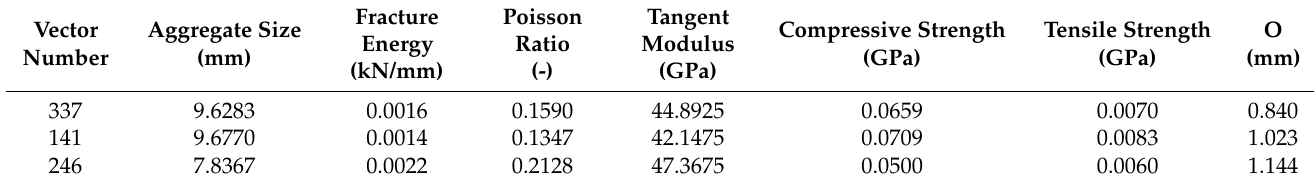
Table 10. Resulting design values of concrete parameters.